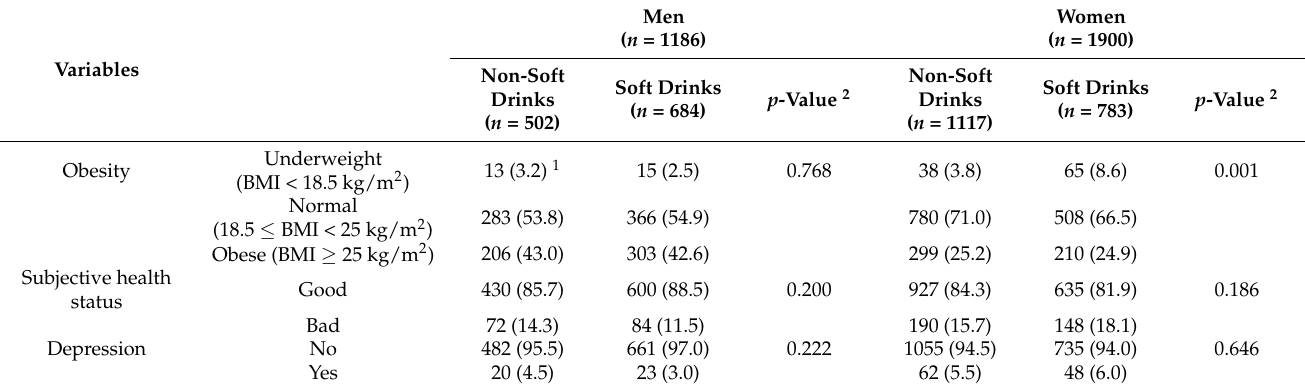
Table 2. Health-related outcomes of participants according to frequency of soft-drink intake by sex.